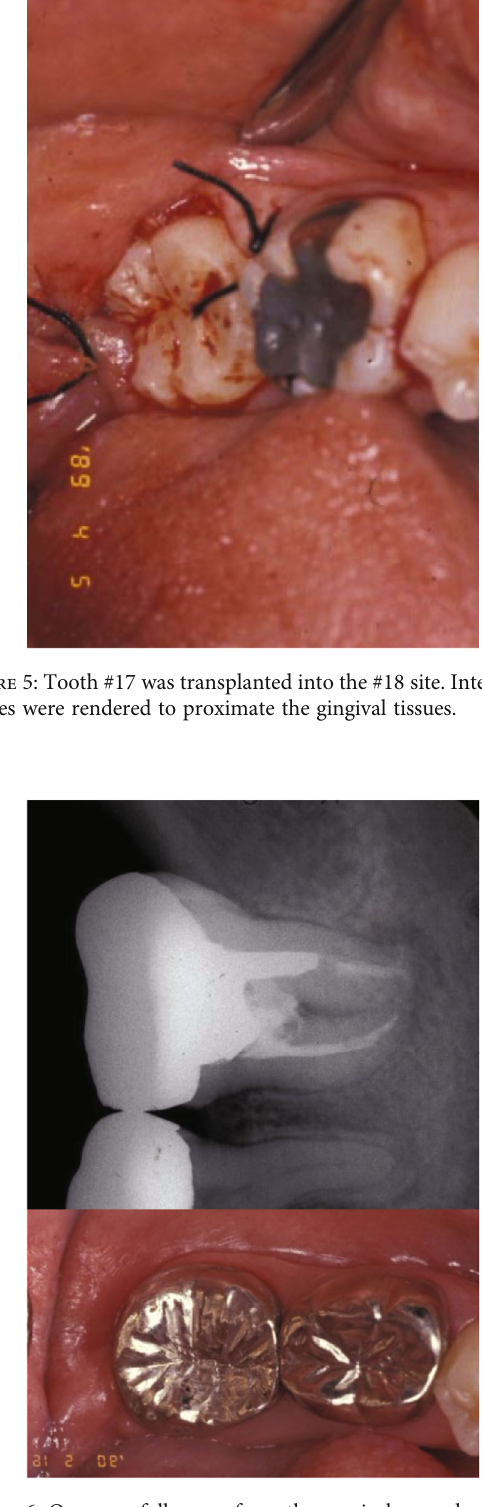
Figure 6: One year follow-up from the surgical procedure. Slight apical radiolucency was noted in the transplanted tooth. Soft tissue healing was uneventful. Slight inadequate root canal fi ling material was noted on the distal root of the transplanted tooth.